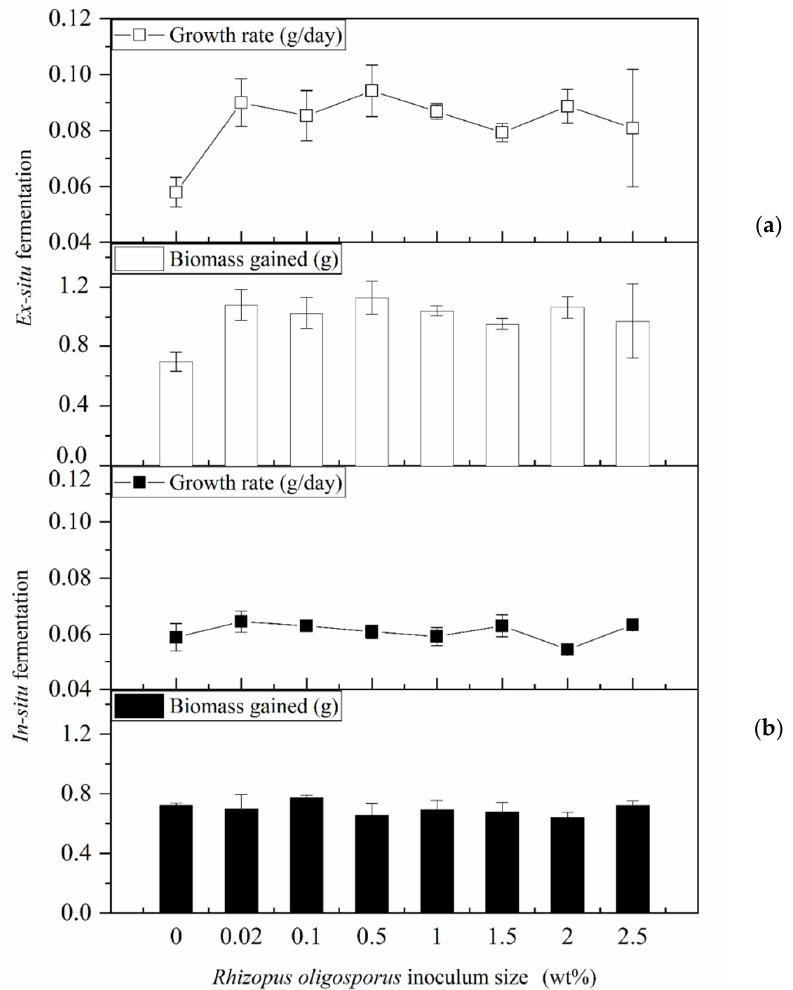
Figure 1. Biomass gained values and growth rates of BSFL fed with in situ—( a ) and ex situ—( b ) fermented CEW, each with increasing inoculum sizes of R. oligosporus. ( b ) fermented CEW, each with increasing inoculum sizes of R.